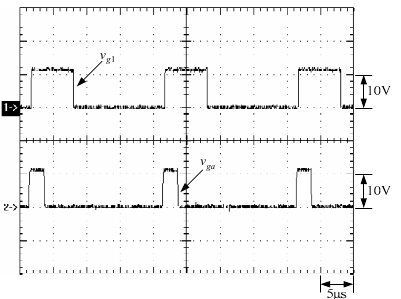
Figure 14. Waveforms pertaining to S 1 and S a at the minimum load: (1) v g 1 ; and (2) v ga . Appl. Sci. 2019 , 9 , x FOR PEER REVIEW